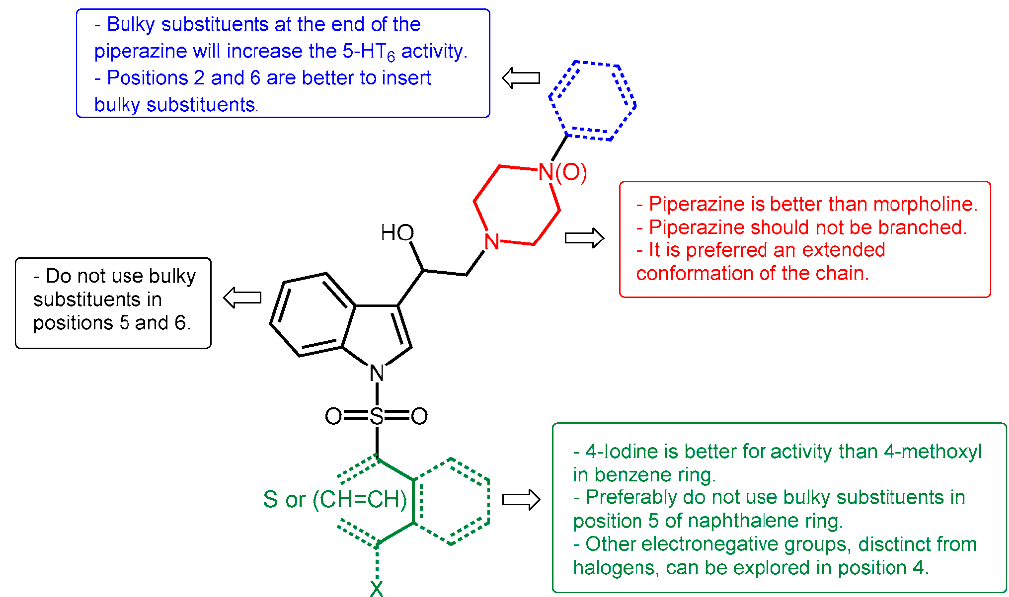
Figure 6. The summary of the SAR founded in the 3D-QSAR study.